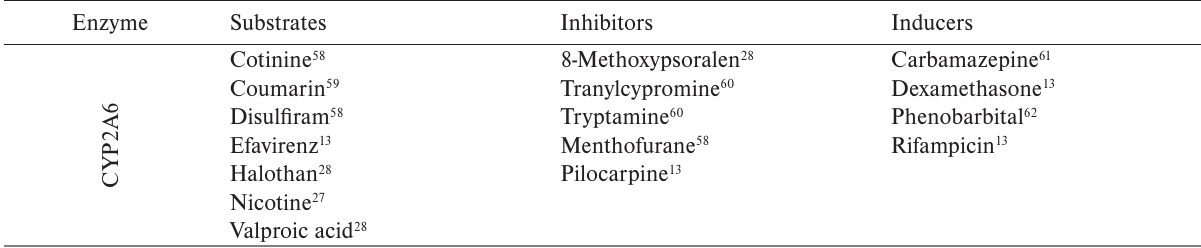
Table 1. Typical substrates, inhibitors and inducers of the human CYP2A6 enzyme. Enzyme Substrates Inhibitors